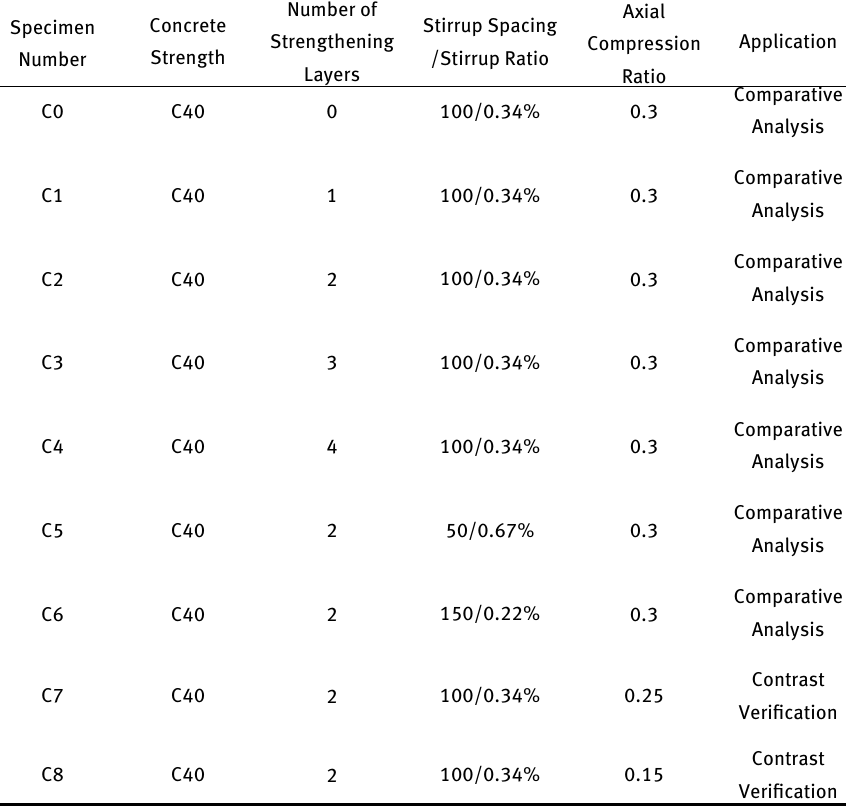
Table 1: Specimen grouping